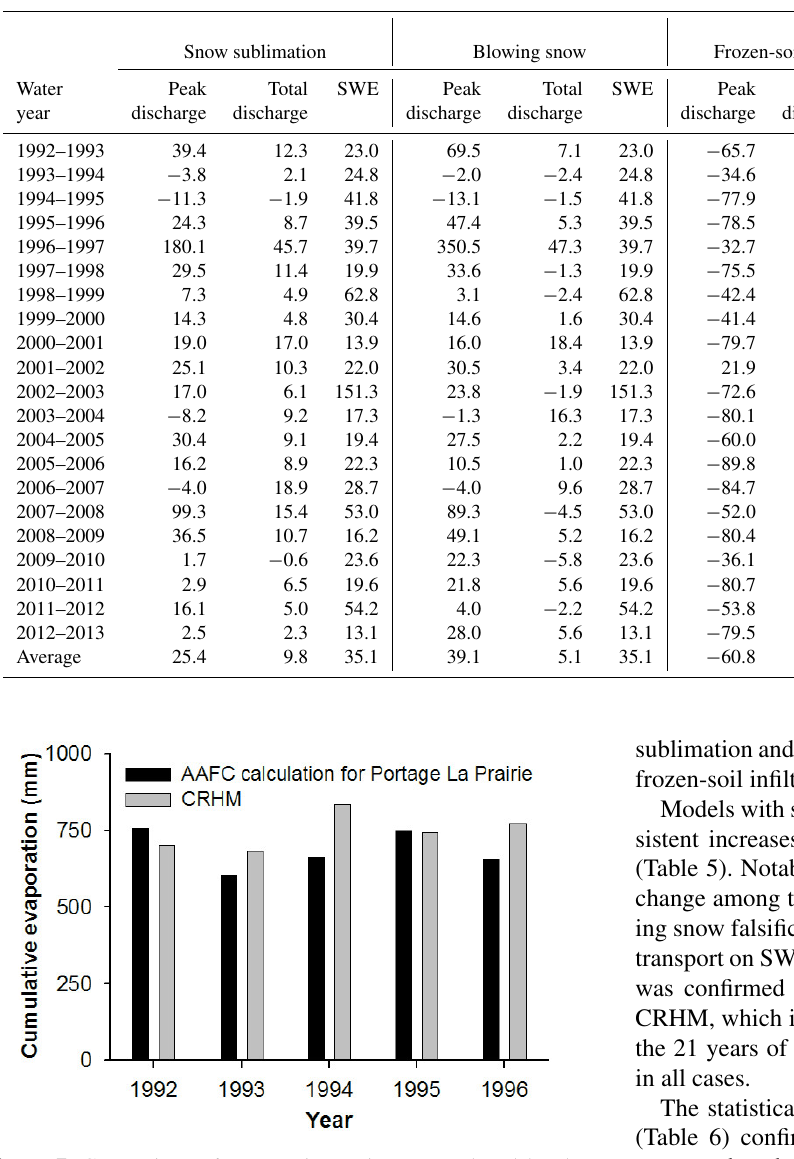
Figure 7. Comparison of evaporation estimates produced by the Agriculture and Agri-Food Canada (AAFC) and CRHM between 1992 and